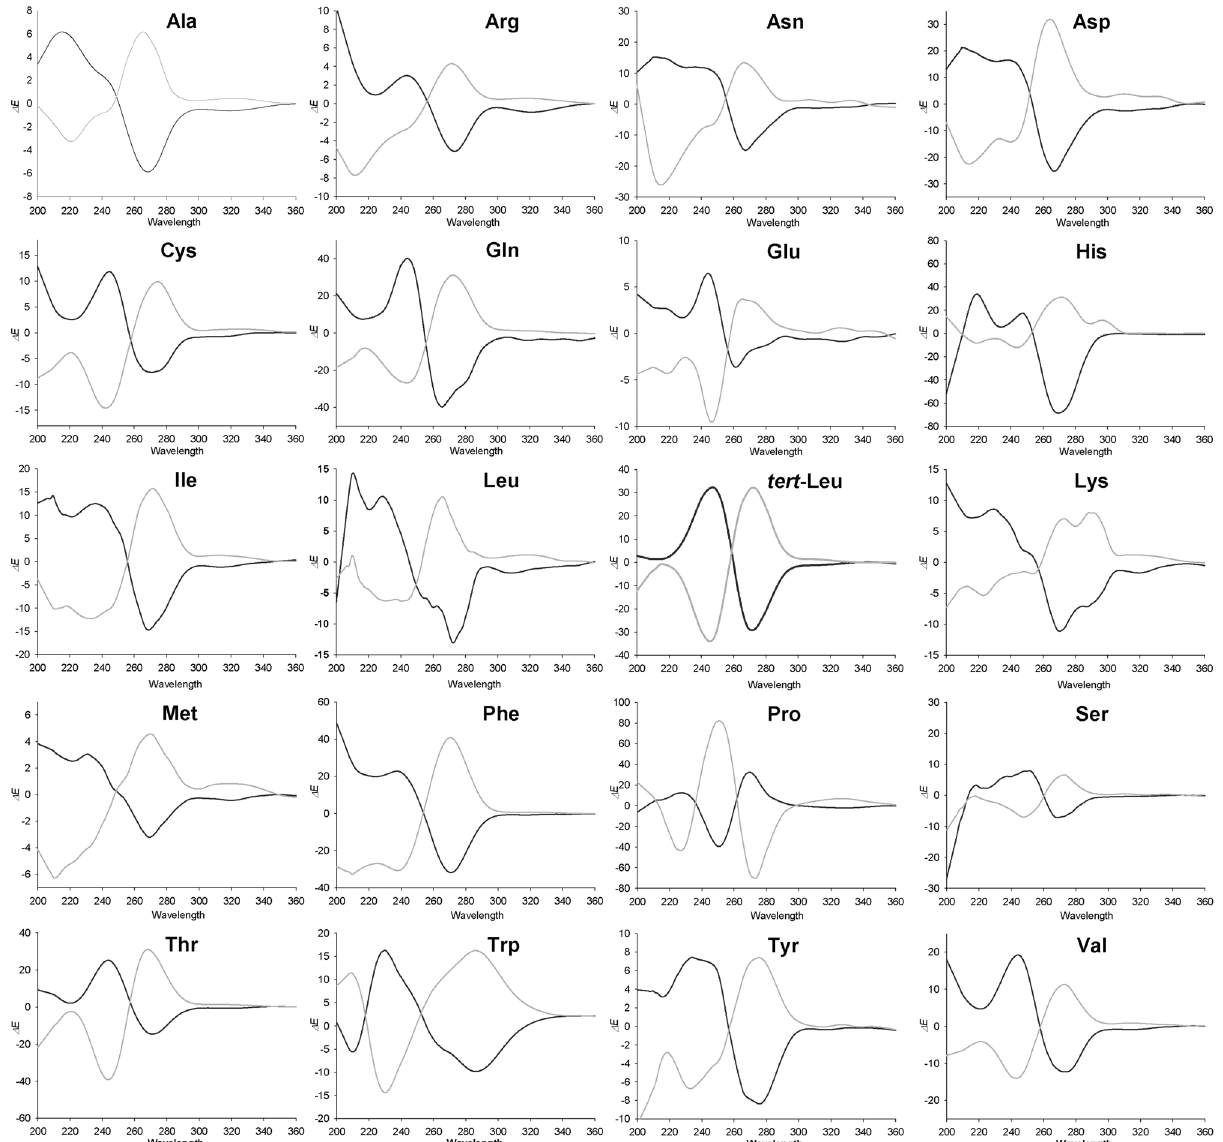
Figure 1. CD spectra of 1 µM of PTH derivatives of 20 pairs of amino acids (d-amino acid spectra are dark, l-amino acid light) in